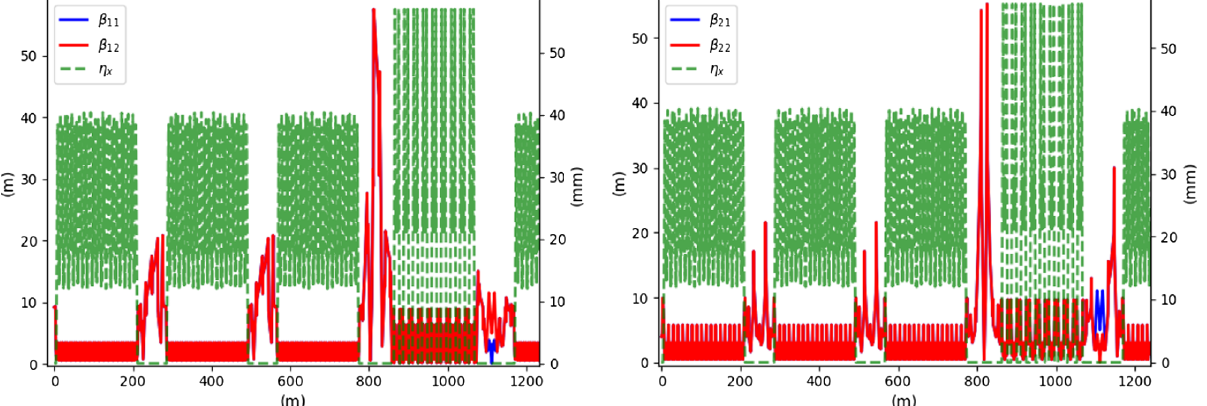
FIG. 6. Mais-Ripken optical functions of the full lattice. Half of the ring (four octants) is shown.